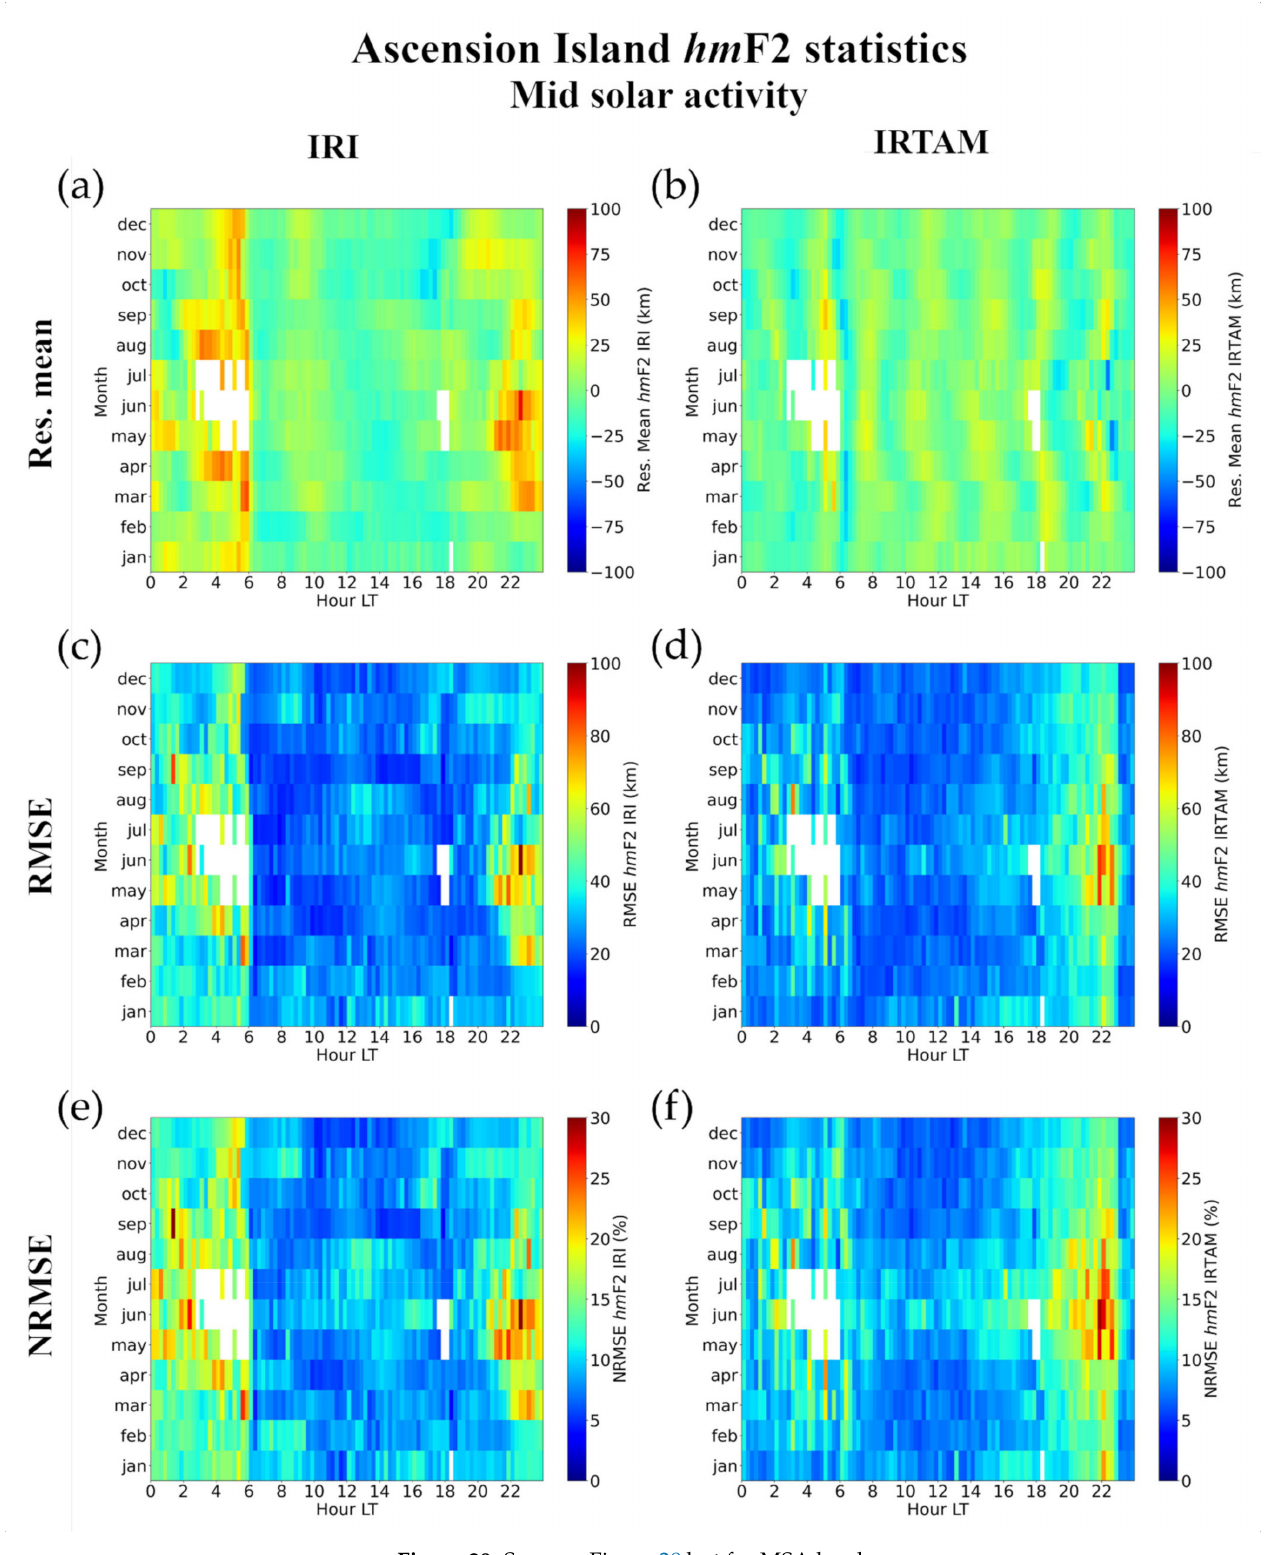
Figure 29. Same as Figure 28 but for MSA